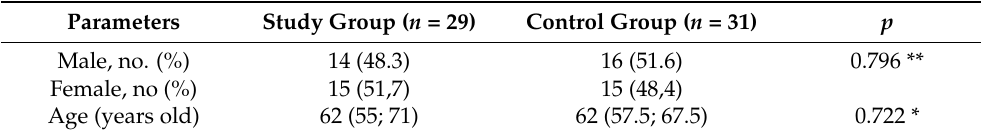
Table 2. Groups comparison. Parameters Study Group ( n = 29) Control Group ( n =